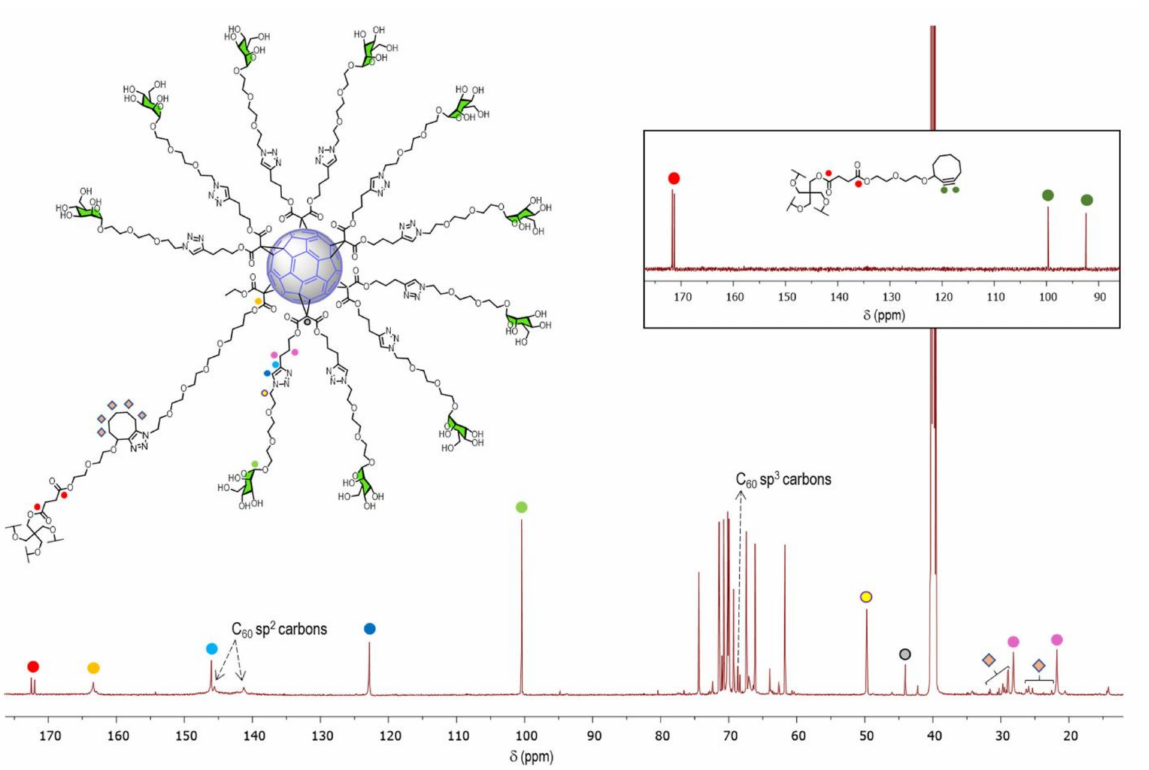
Figure 2. 13 C NMR of compound 3 in DMSO- d 6 (175 MHz) and compound 15 (inset) in CDCl 3 (75